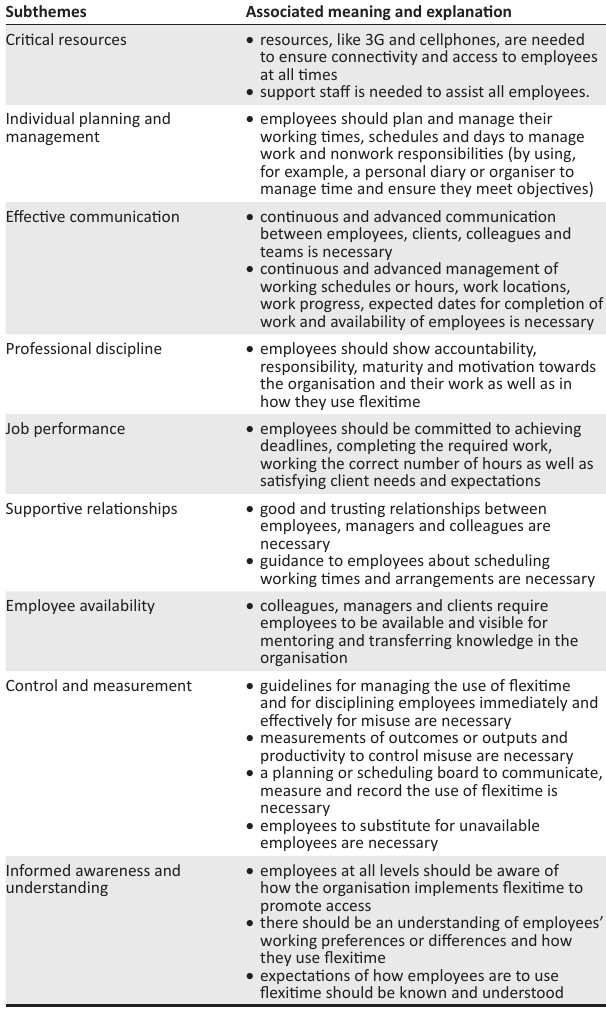
TABLE 3: Requirements for the effective use of